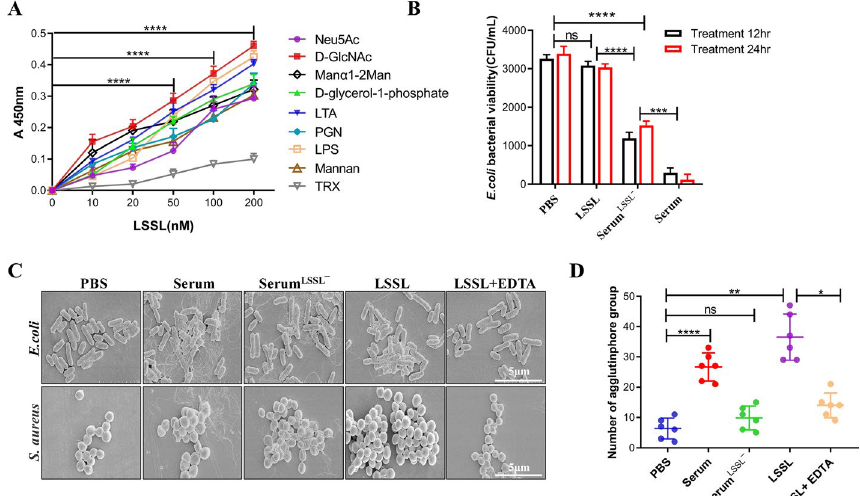
Fig. 4 LSSL has strong bacterial agglutination effect. A ELISA showing the interaction between LSSL and microbial components and glycans. Plates were coated with 20 μg components, washed, and incubated overnight with LSSL at 4 °C, followed by detection using an anti-LSSL antibody. One representative experiment of three is shown ( n 3 technical replicates, data are representative of more than three = independent experiments). Background absorbance without protein was subtracted. B The determination of bacterial activities of serum, LSSL, and LSSL-depleted serum on E. coli and S. aureus after 12 or 24 h. Data are presented as the mean percentage SD of three independent experiments. C Scanning electron microscopy ± (SEM) analysis of E. coli and S. aureus after treatment with LSSL. E. coli and S. aureus were incubated with PBS and used as controls. The concentration of EDTA used was 50 μg/mL. Scale bar, 5 µm. D Agglutination of GFP- E. coli by LSSL. Different components were incubated with FITC-labeled E. coli (10 5 cells per well) in PBS for 1 h at room temperature and were examined using a high-content screening system ( n 3, = **** P < 0.0001, *** P < 0.001, ** P < 0.01, and * P <